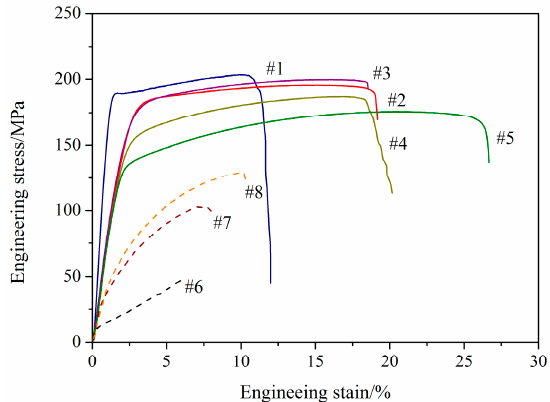
Figure 6. Tensile engineering stress–strain curves, and solid line represents current trials: ( #1 ) as-extruded sample; ( #2 ) 1-pass ECAPed sample; ( #3 ) 2-pass ECAPed sample; ( #4 ) 3-pass ECAPed sample; ( #5 ) 4-pass ECAPed sample; dash line represent the trials by Ref. [29]; ( #6 ) as-cast pure Mg; ( #7 ) 4-pass ECAP at 360 °C (Mg); ( #8 ) 1-pass ECAP at 360 °C + 3-pass ECAP at 300 °C (Mg).